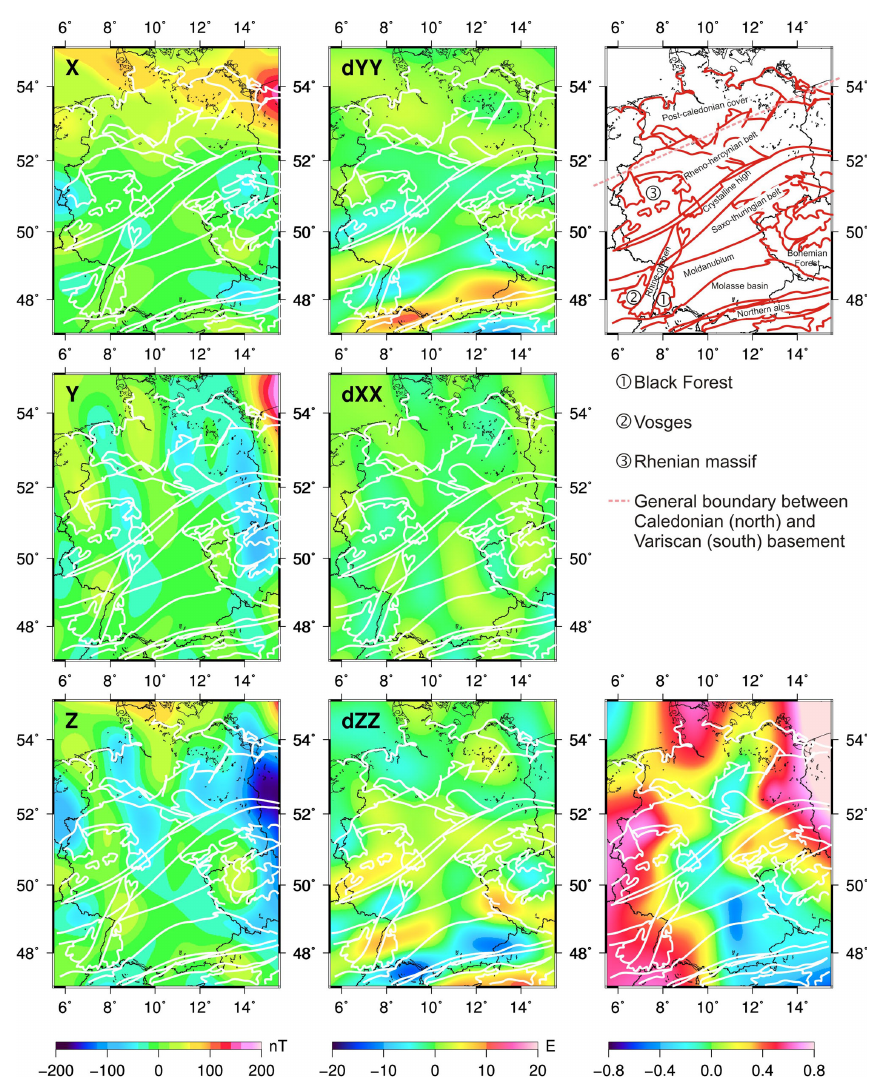
Figure 9. Comparison of long-wavelength magnetic and gravity anomalies for Germany. Left: lithospheric field from EMM2010 model of SH degrees 15–200 for north ( X ), east ( Y ), and vertical ( Z ) components from top to bottom. Middle: gravity gradients in north ( dYY ), east ( dXX ), and vertical ( dZZ ) directions from top to bottom from GOCE-DIR5 model up to SH degree 200. Right: labelled outline of large-scale tectonic features (top) after Berthelsen et al. (1992) and correlation between vertical component magnetic and gravity anomalies